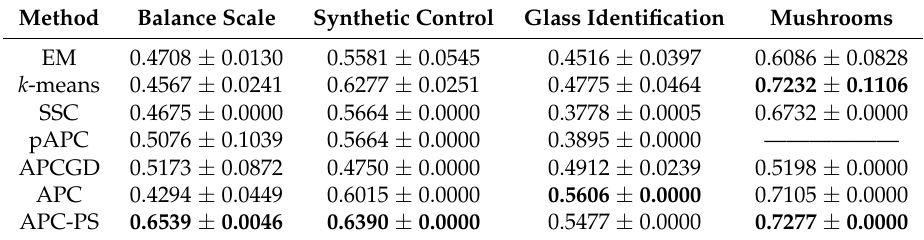
Table 3. Experimental results (average ± standard deviation) on four datasets under evaluation